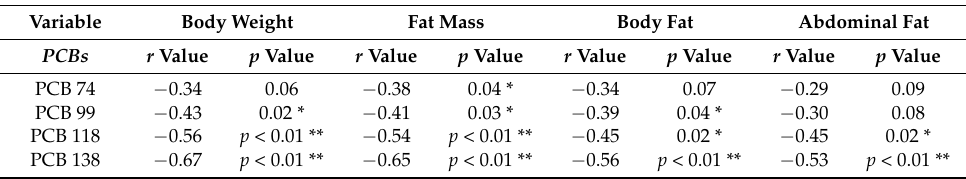
Table 8. Pearson correlation coefficients for the percent change in body composition and PCBs following the WM Phase 2